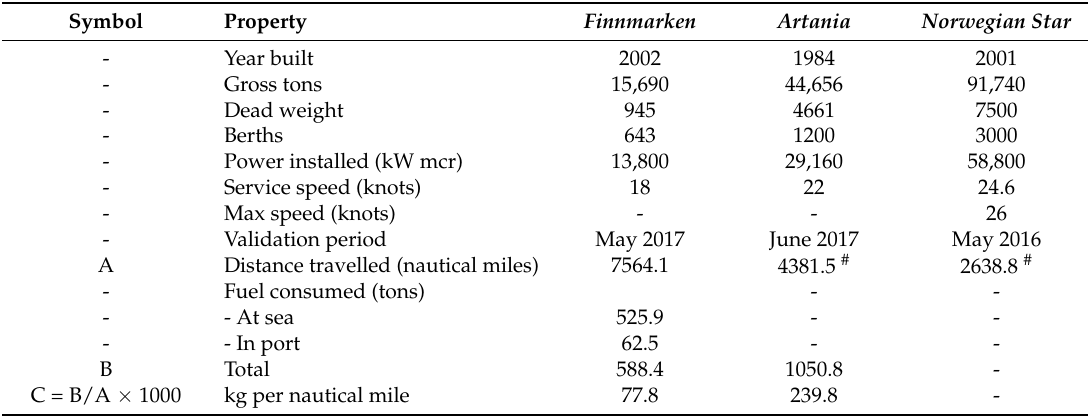
Table 7. Ships used in model validation.